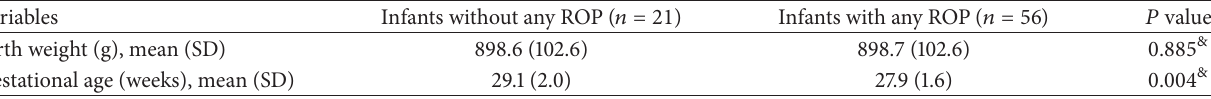
Table 2: Different birth weight and gestational age between infants with or without retinopathy of prematurity. Variables Gestational age (weeks), mean